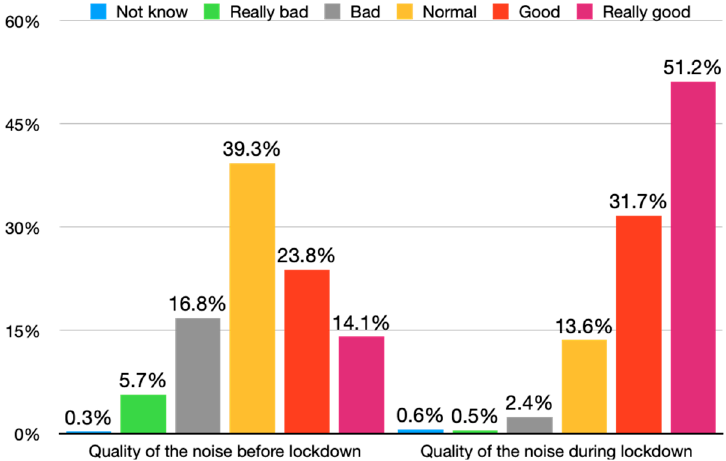
Figure 10. Sound quality before and during lockdown.